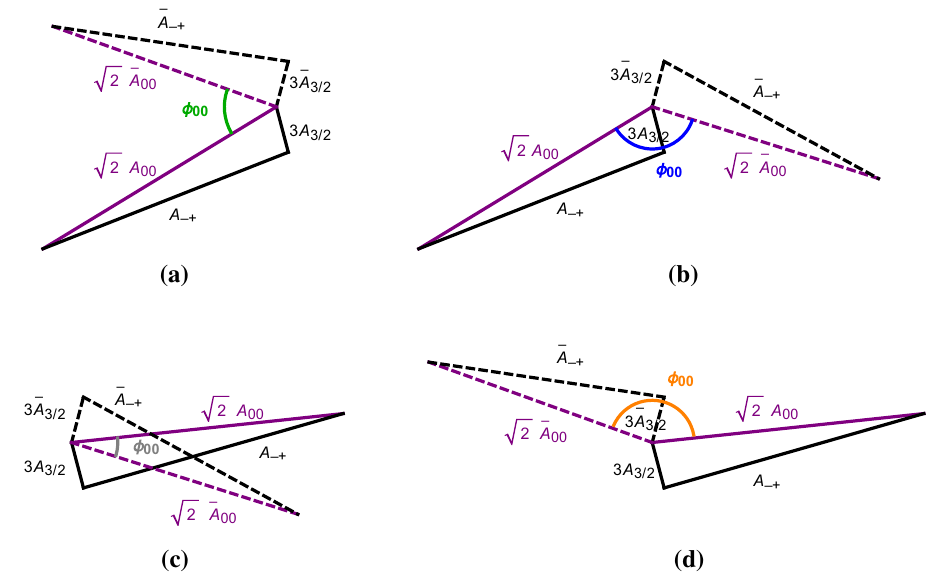
Fig. 6 Thefourorientationsoftheamplitudetrianglesforcurrentdataand A π 0 K S to the contours in the A π 0 K S